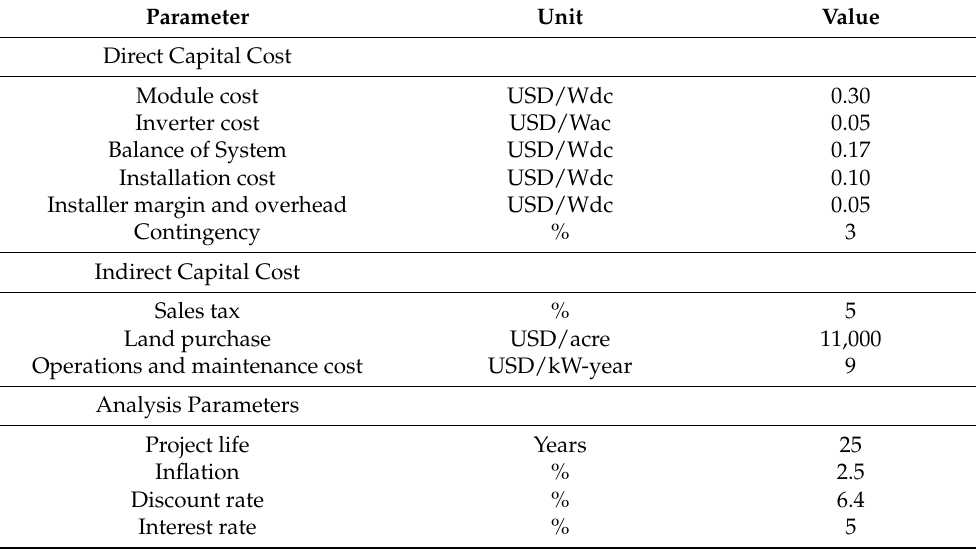
Table 7. Commercial parameters for PV module. Adapted from